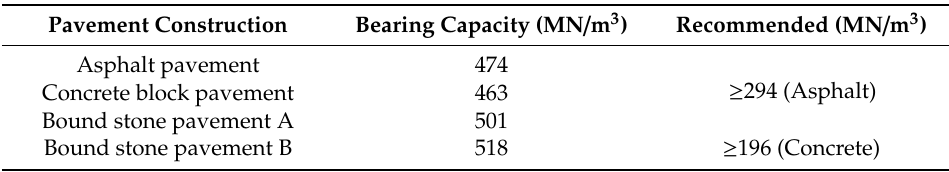
Table 9. Bearing capacity of sub-base